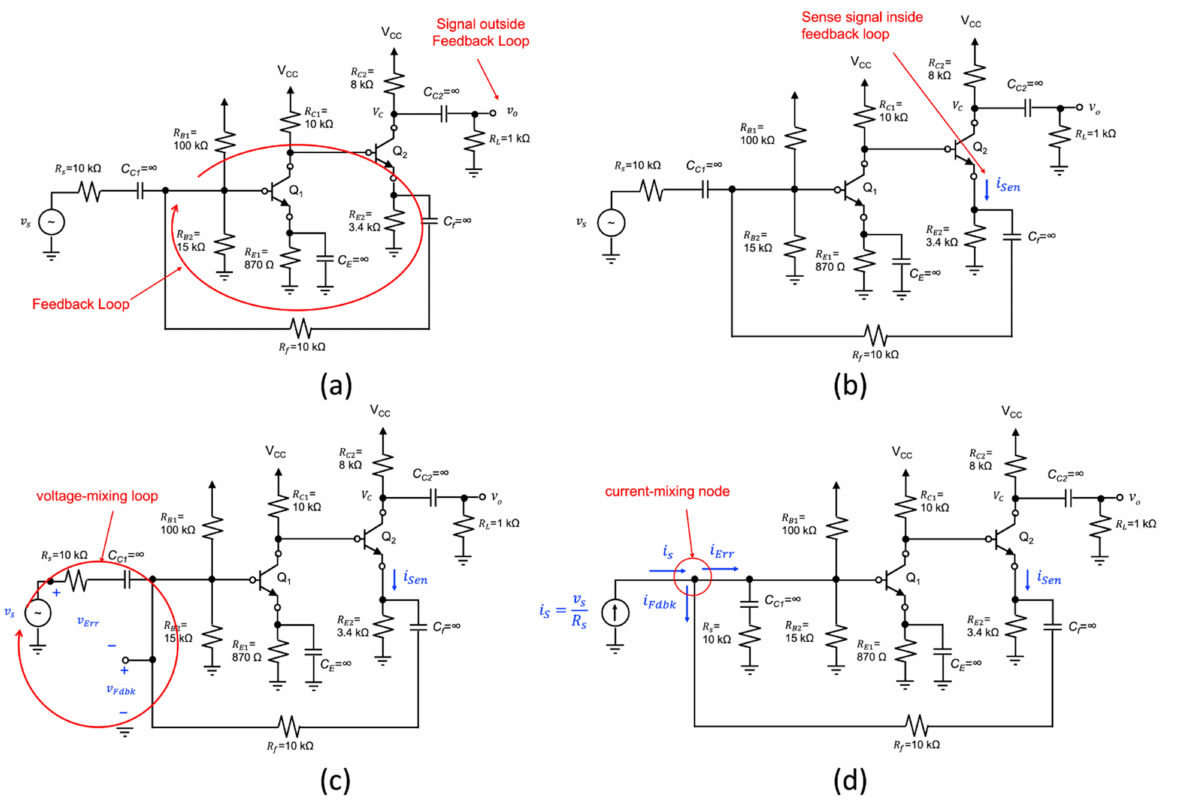
Figure 13. Preparing a current-mixing/current-sensing feedback circuit for feedback parameters isolation: ( a ) Identifying the feedback loop. ( b ) As the output voltage is outside the feedback loop of the amplifier, a sensing current has been identified that is inside the loop. ( c ) Identifying the system variables that form a voltage-mixing loop that is compliant with Black’s topology. ( d ) A fully compliant circuit arrangement that meets the definition of a current-mixing/current-sensing